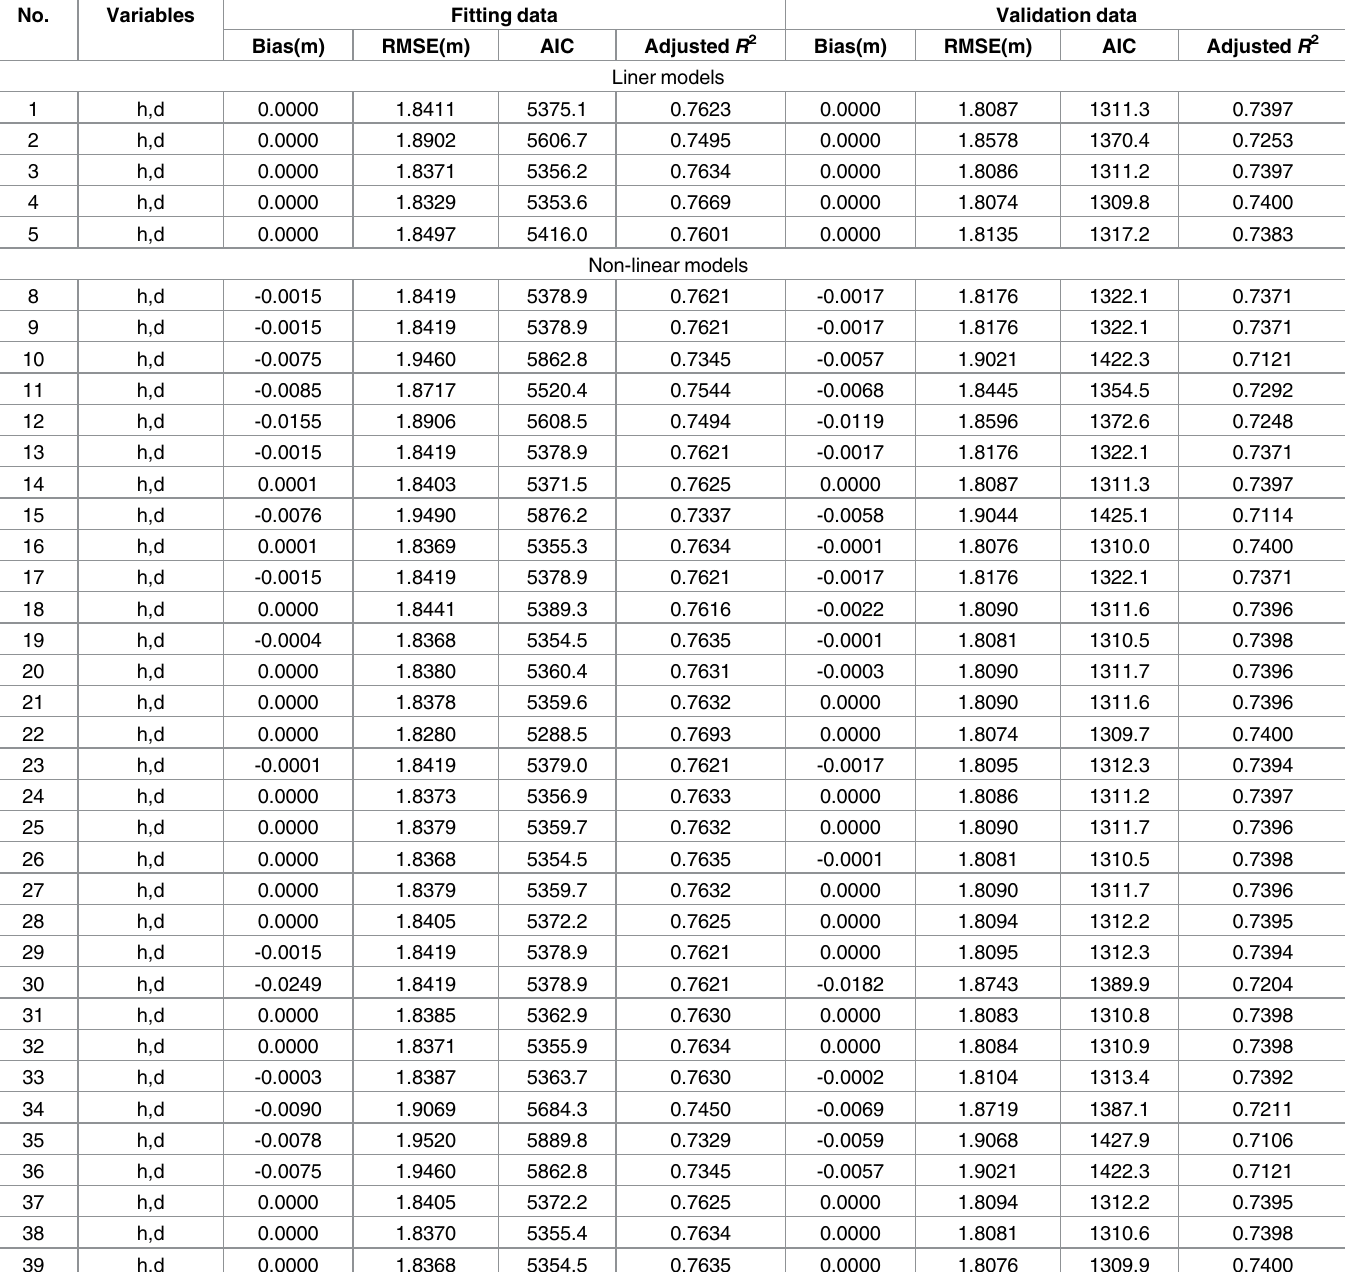
Table 3. Calibration data and validation data adaptive statistics for models in Group 1. doi: